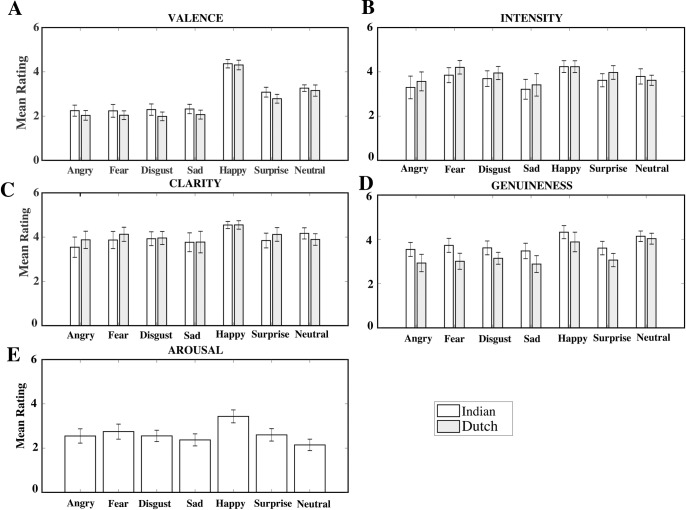
Histogram for valence, intensity, clarity, genuineness and arousal.Bar plots comparing mean ratings between Indian (white bars) and Dutch (grey bars) participants for valence (A), intensity (B), clarity (C), genuineness (D). For arousal (E) parameter mean ratings only for Indian participants is shown. The error bars represent standard error of mean.